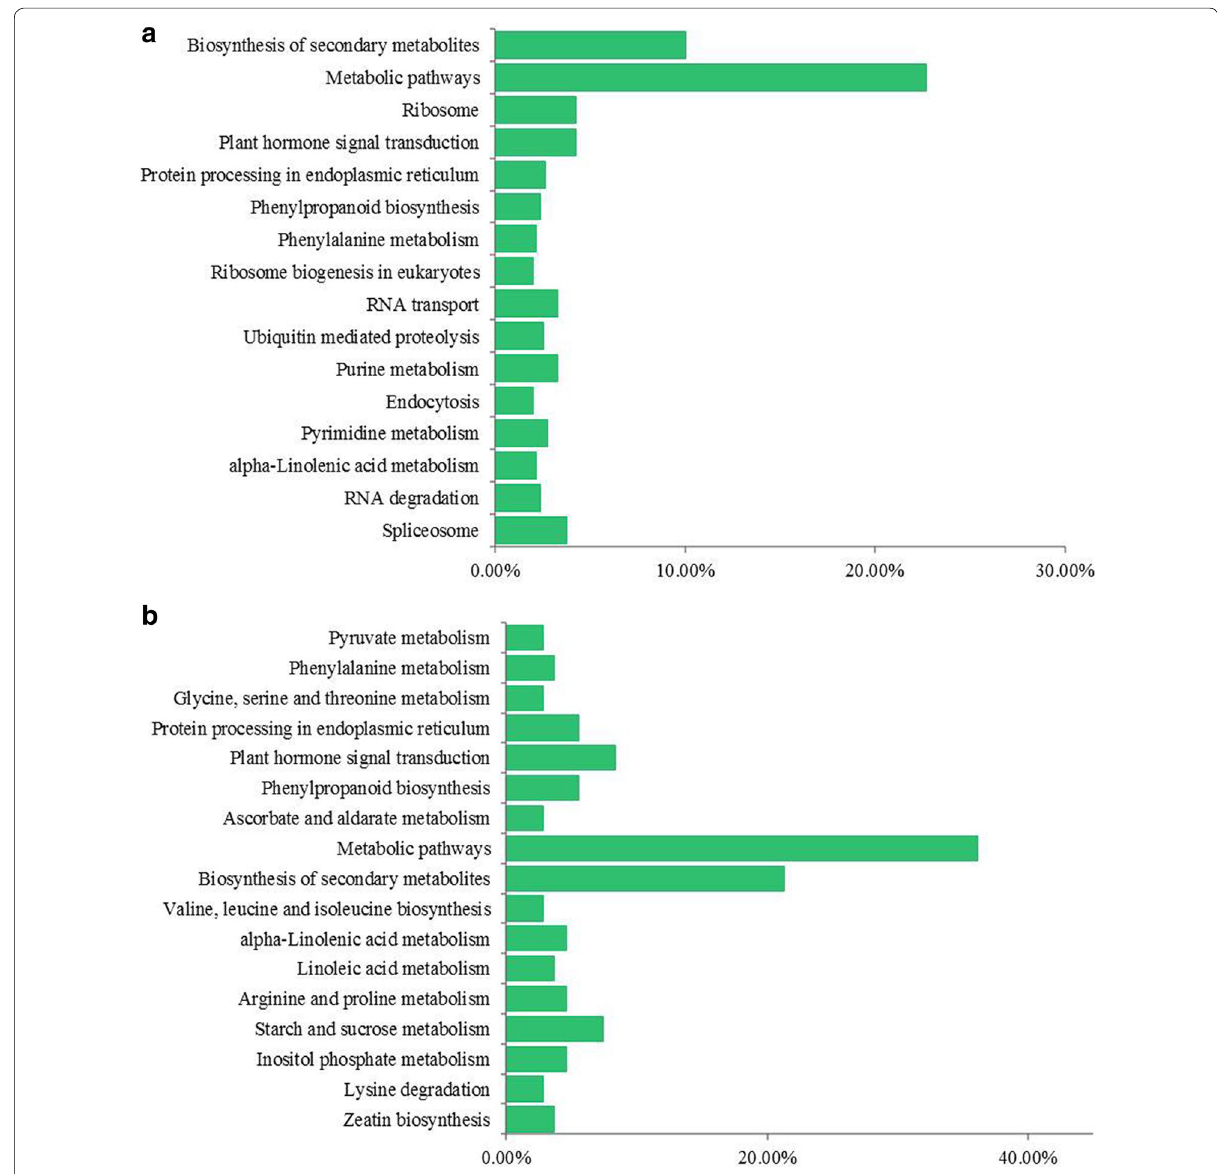
Fig. 4 Kyoto encyclopedia of genes and genomes (KEGG) pathway enrichment of differently expressed genes (DEGs) in a pairwise R4B1-5-vs-R2B1-5 and b pairwise